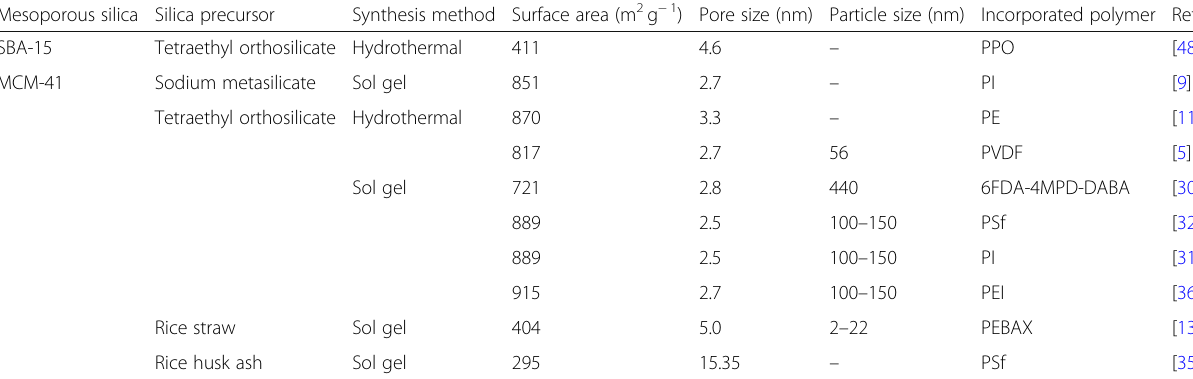
Table 2 Mesoporous silica for mixed matrix membranes (MMMs) fabrication Mesoporous silica Silica